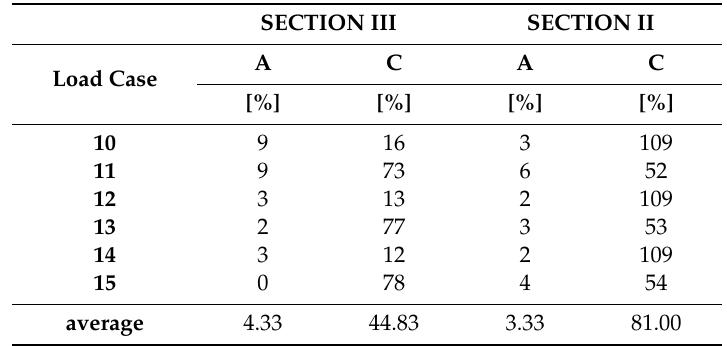
Table 2. Torsional moment measurement errors. Figure 13. Bending moment measurement error—Section II.